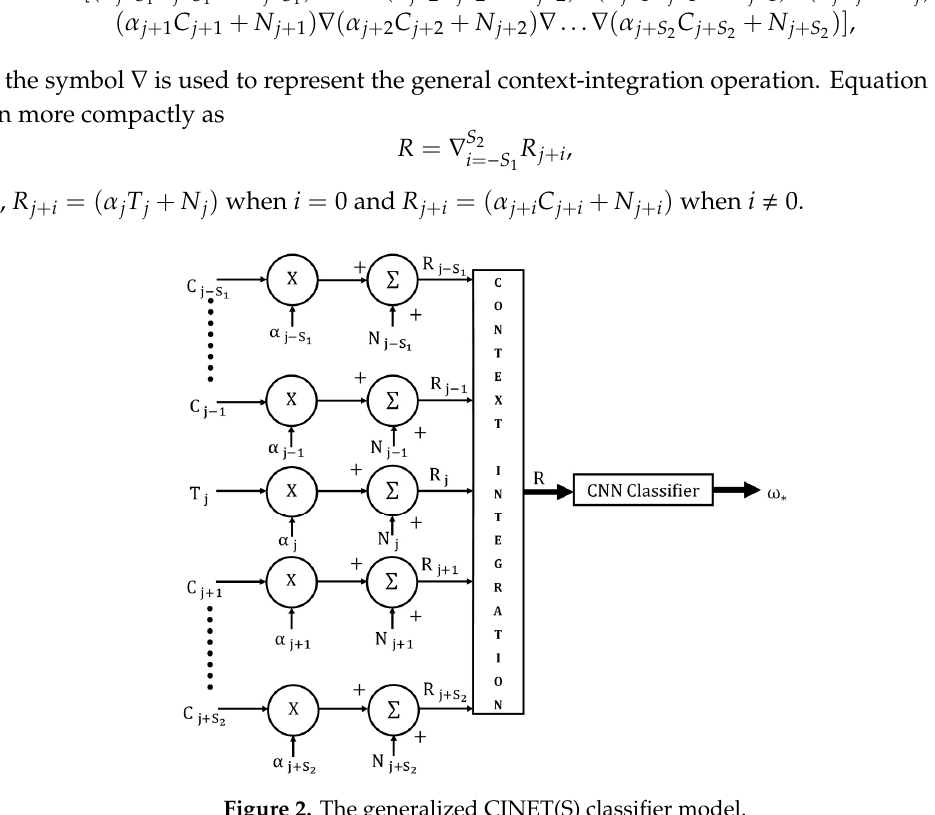
Figure 2. The generalized CINET(S) classifier model.